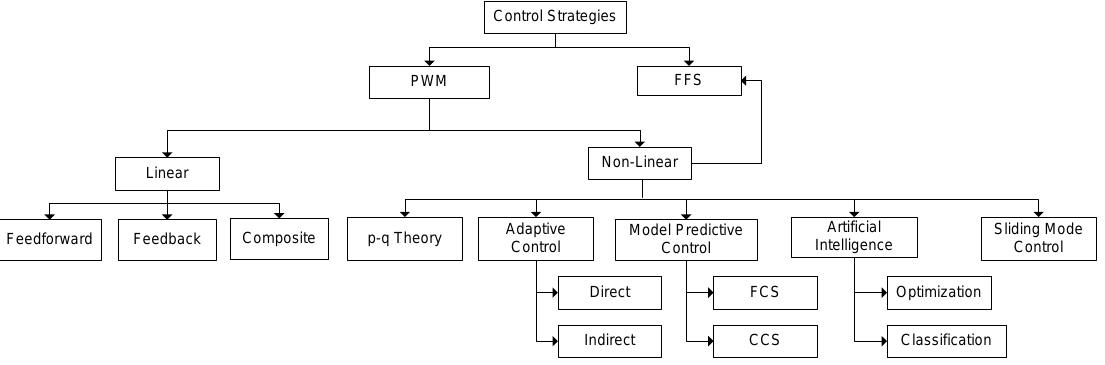
Figure 10. Overview of control strategies present in a PQ compensation device [84,115].